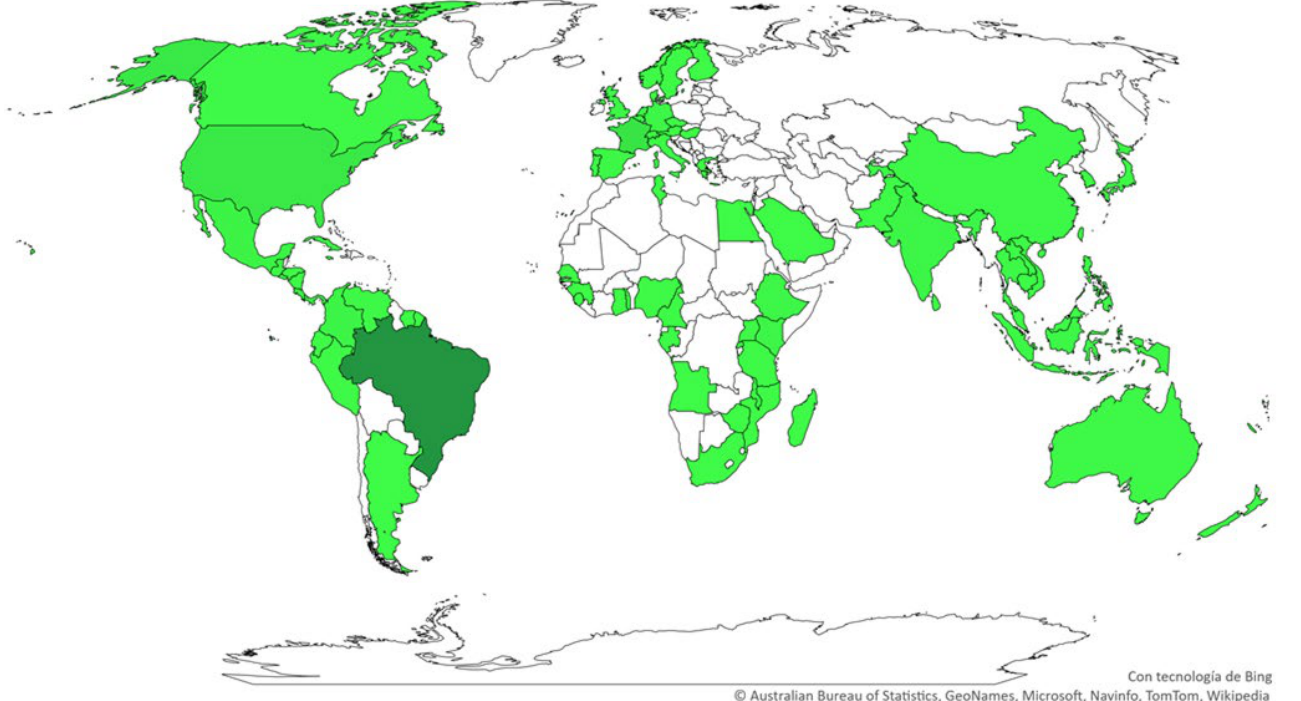
Figure 3. Geography of documented scientific production.